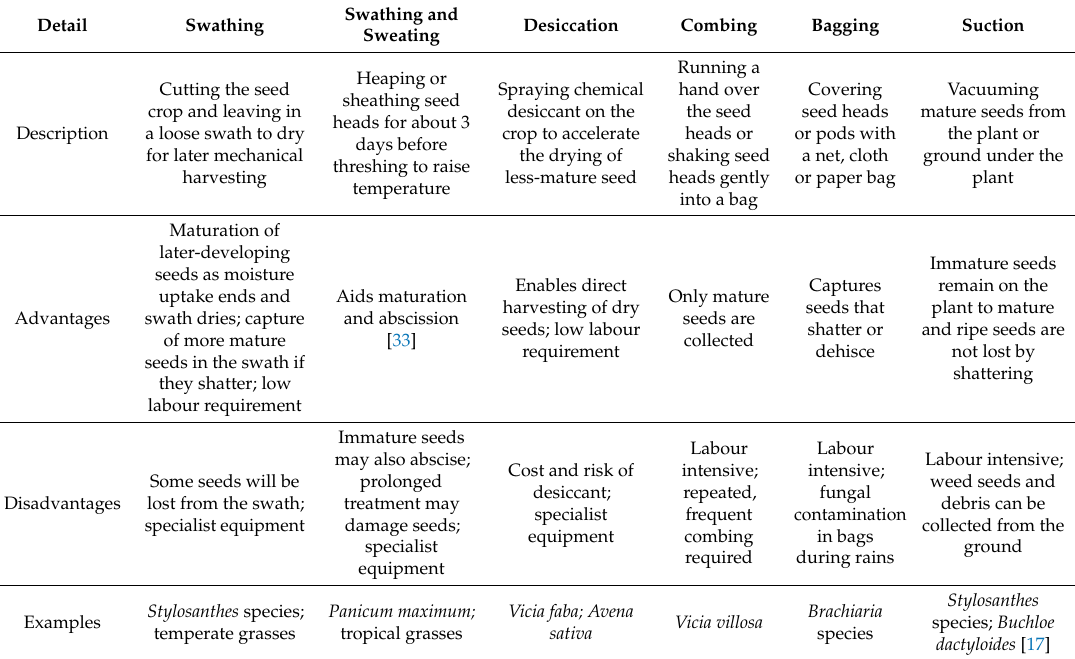
Table 3. Seed harvesting techniques for accessions which show considerable plant-to-plant variation in the timing of seed